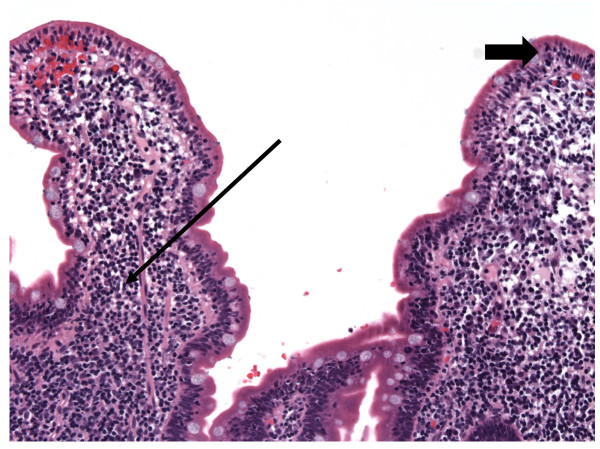
Duodenal biopsy before steroid therapy demonstrating regions with persistent IEL (large arrow) with marked LP lymphocytosis (small arrow).